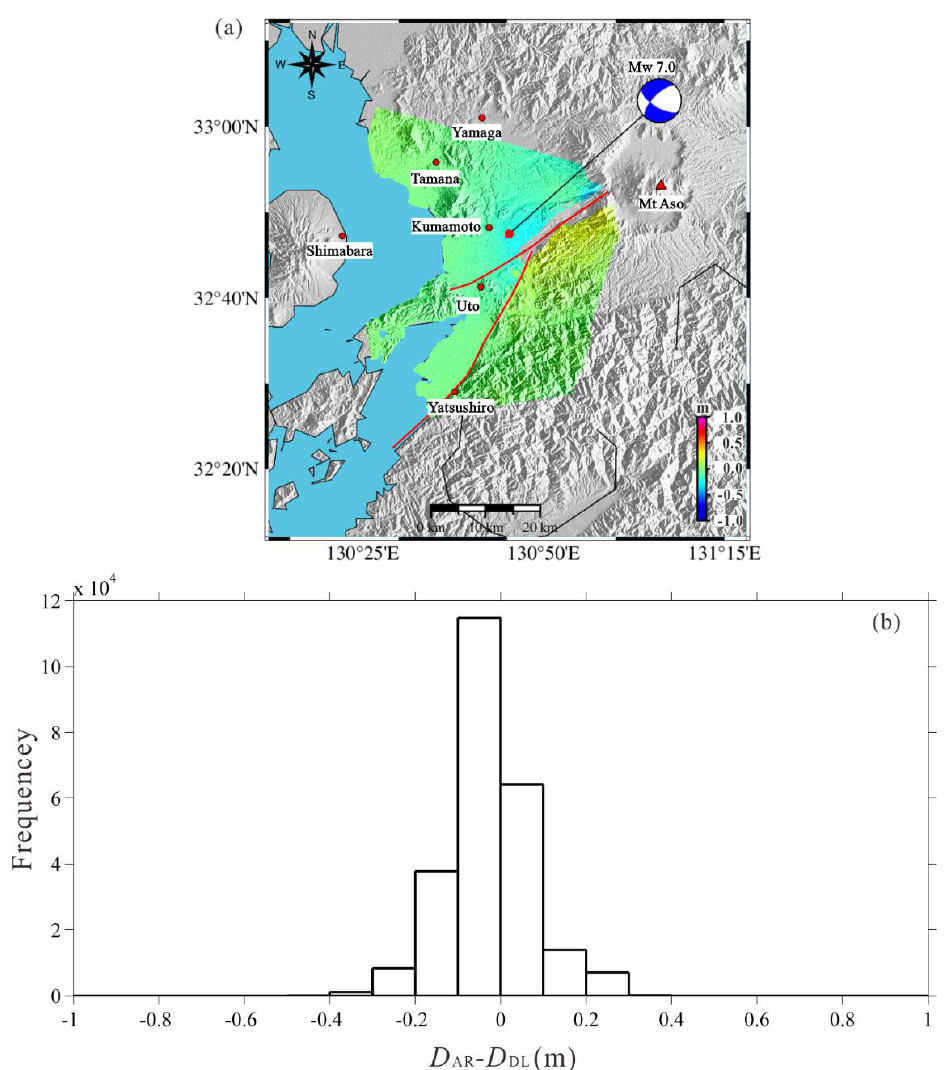
Figure 10. Comparison of the deformation measured by AR and DL InSAR. ( a ) The differences in displacements measured by AR InSAR ( D AR ) and DL InSAR ( D DL ). ( b ) The distribution of the differences.